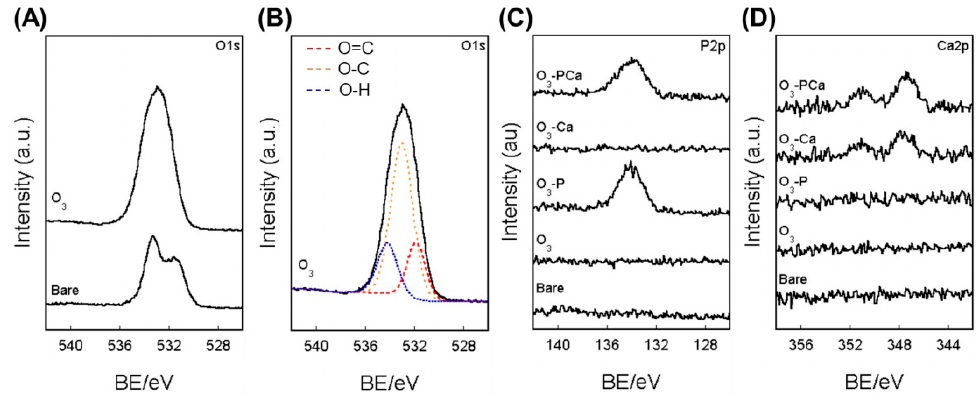
Figure 2. XPS analyses. ( A ) O1s spectra, ( B ) O1s peak deconvolution of O 3 , ( C ) P2p, and ( D ) Ca2p spectra. BE: binding energy, Bare: untreated PEEK, O 3 : ozone-gas-treated PEEK, O 3 -P: phosphate-immobilized PEEK, O 3 -Ca: calcium-immobilized PEEK, O 3 -PCa: phosphate and calcium co-immobilized PEEK.